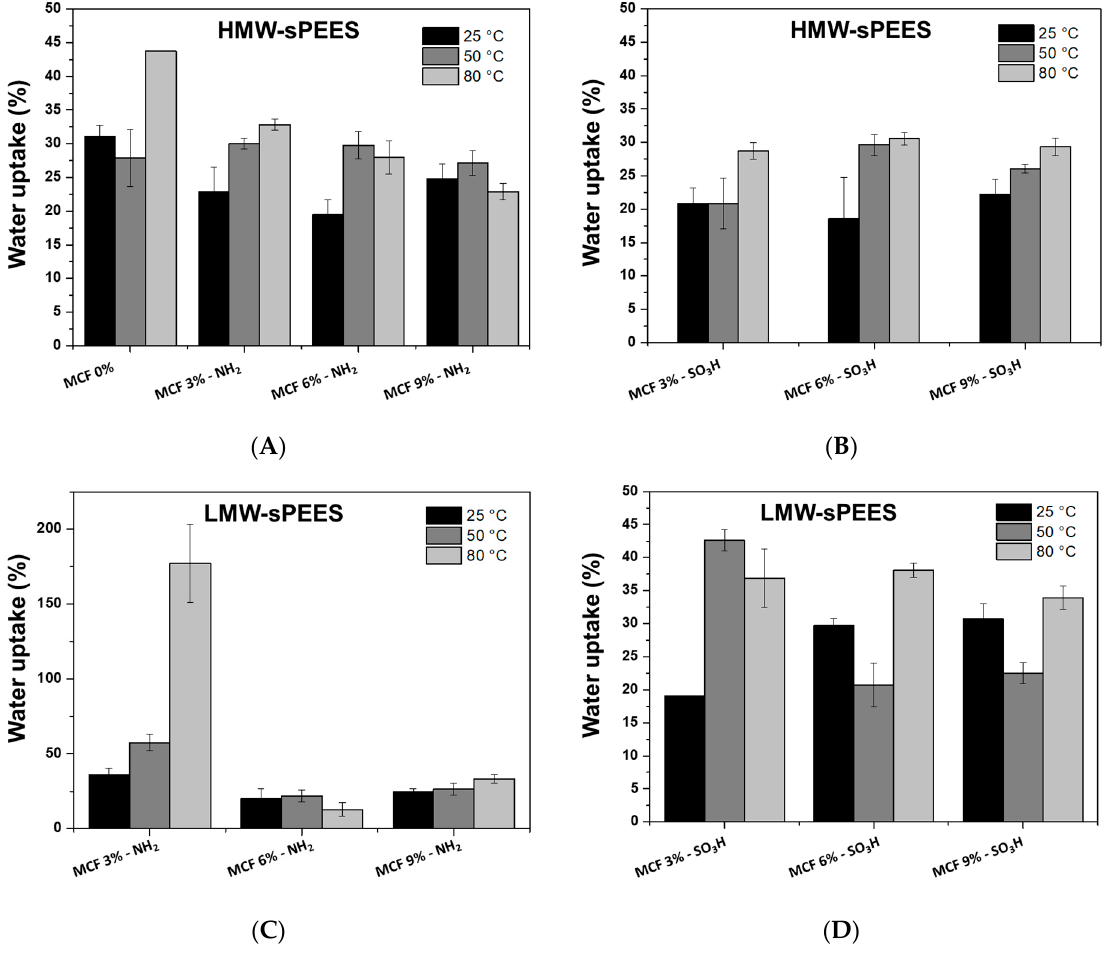
Figure 14. Measurements of water retention (%) at different temperatures for membranes prepared from ( A ) HMW-sPEES MCF-NH 2 ; ( B ) HMW-sPEES MCF-SO 3 H; ( C ) LMW-sPEES MCF-NH 2 ; and ( D ) LMW-sPEES MCF-SO 3 H.